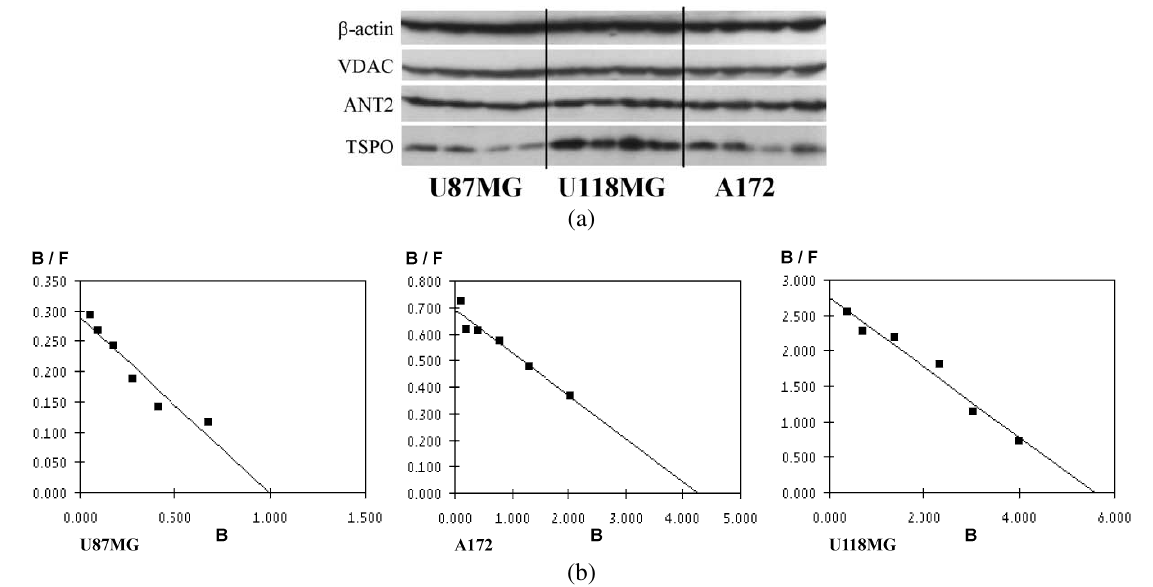
Fig. 1. (a) Examples of Western blots showing the presence of TSPO, ANT2 and VDAC in the U87MG, U118MG and A172 cell lines. β -actin was used as a reference protein. Each lane presents a different sample, i.e. cells taken from one culture flask. (b) Representative Scatchard plots demonstrating the binding of the specific TSPO ligand [ 3 H]PK 11195 to membrane homogenates of U87MG, A172 and U118MG human glioblastoma cells. The X -axis indicates the amount of bound [ 3 H]PK 11195 in fmol/mg protein and the Y -axis indicates the ratio of bound over free [ 3 H]PK 11195. Abbreviations in the figure: B = bound; B/F = bound /